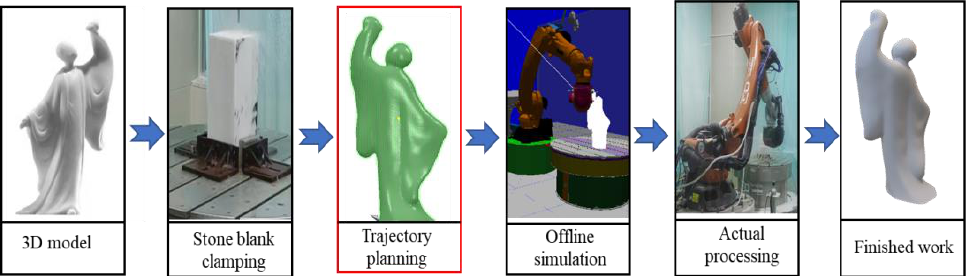
Figure 1. The complex-shaped stone-grinding process by robotic manipulators.